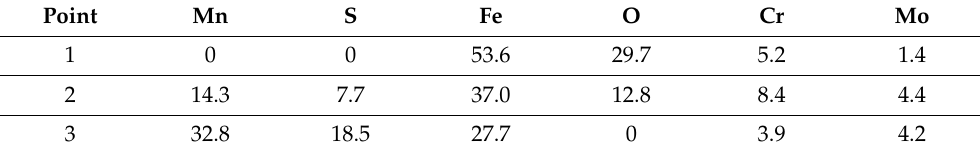
Figure 11. Wear morphology of SLD-MAGIC under a normal load of 10 N. Table 5. The atomic percentage of SLD-MAGIC in SEM images by EDS.